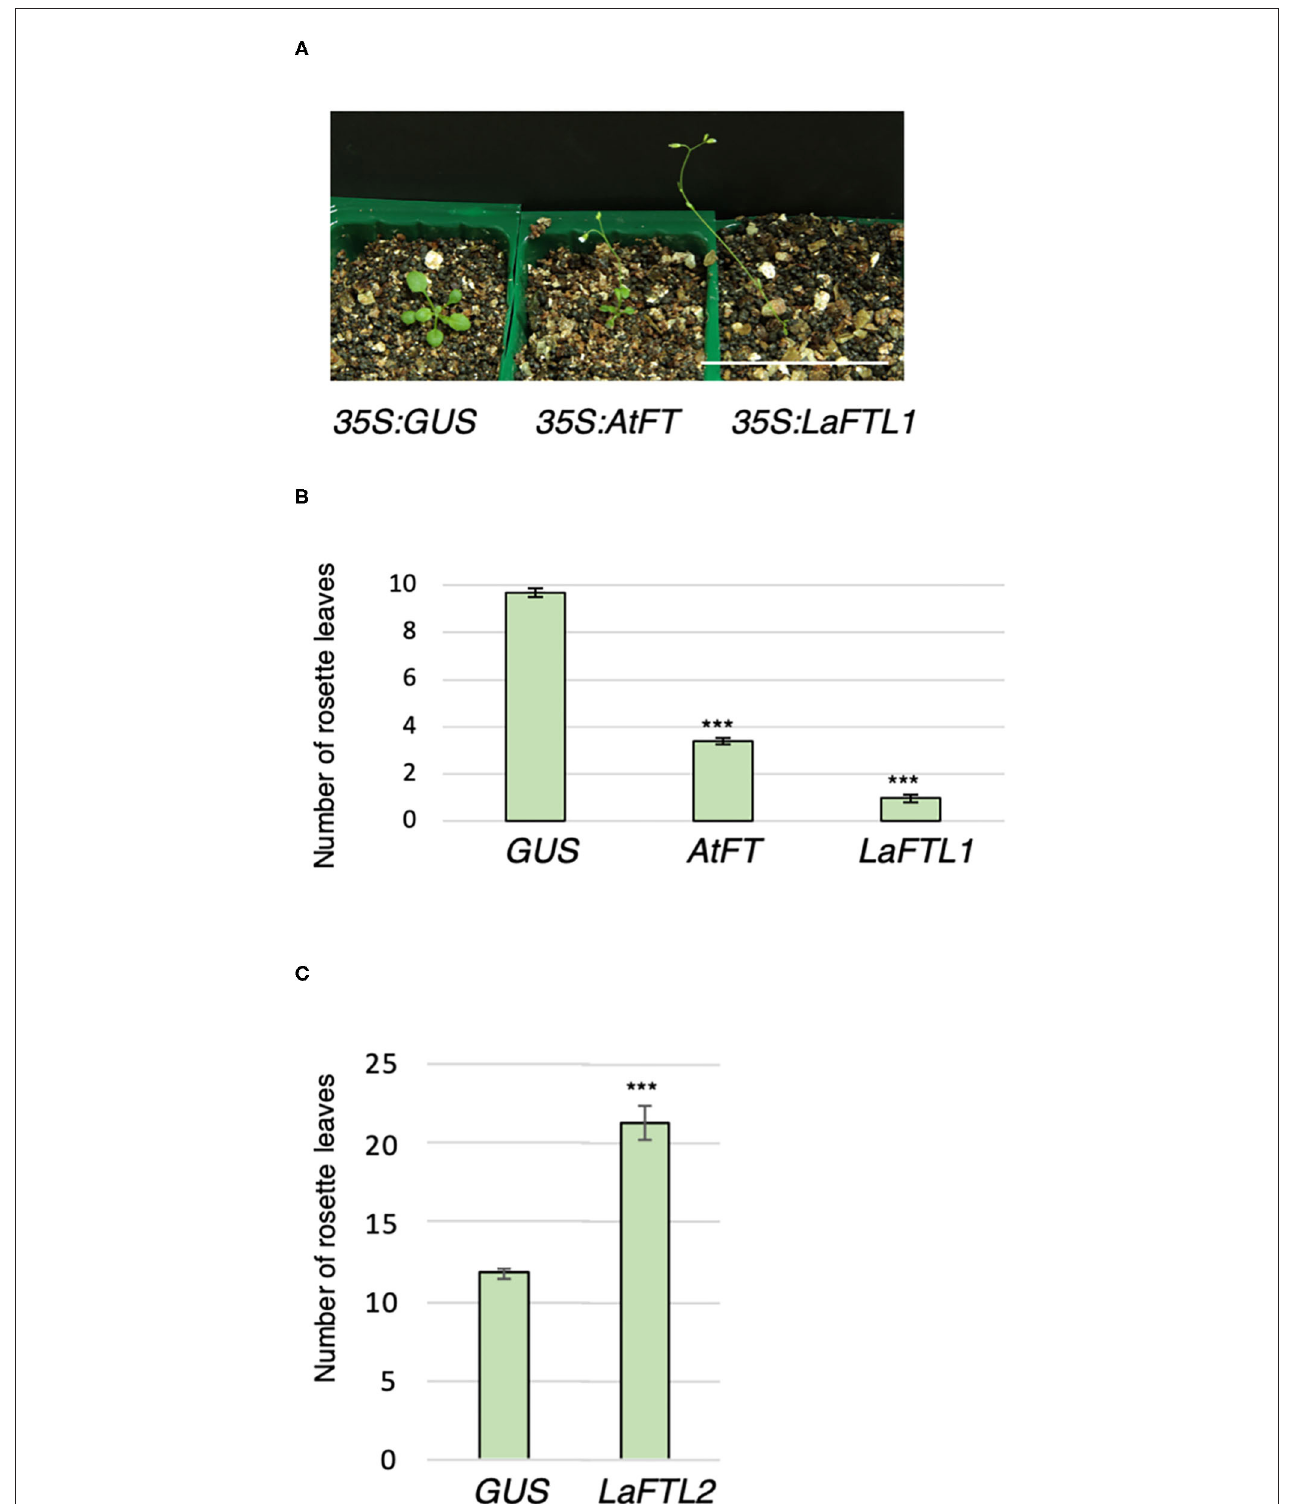
FIGURE 7 | 18 days LaFTL-oe in Arabidopsis. Ectopic expression of LaFTL1 accelerated flowering in Arabidopsis . (A) The flowering phenotype of transgenic Arabidopsis plants at 15 days after seeding. Genotypes are indicated below the photo. GUS and Arabidopsis AtFT were analyzed as a negative and positive control, respectively. Bar = 5cm. (B) The number of rosette leaves on transgenic plants overexpressing LaFTL1, AtFT, or GUS . (C) The number of rosette leaves on transgenic plants overexpressing GUS or LaFTL2 . Asterisks denote statistically significant differences determined by Student’s t -test ( P < 0.001). Bars indicate SE.